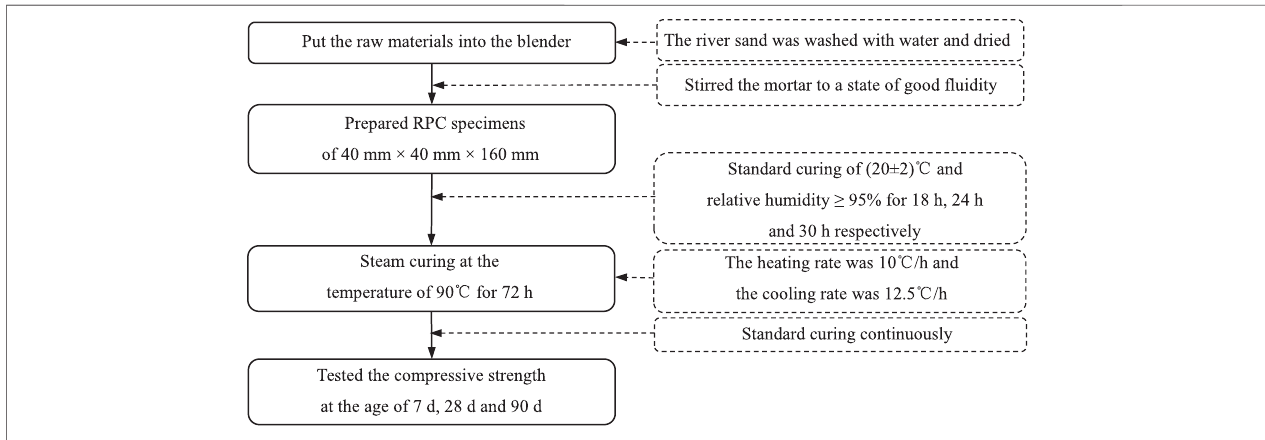
Figure 1 | Schematic diagram of RPC